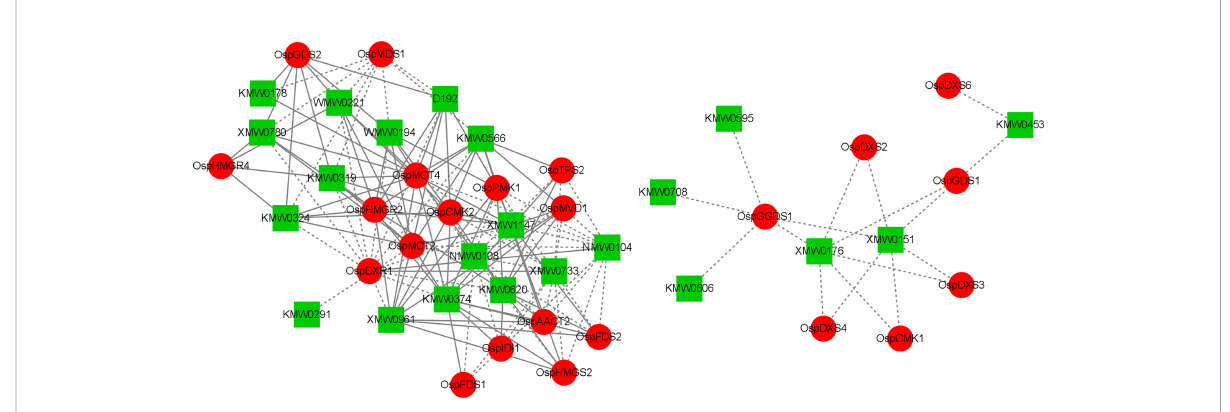
FIGURE 10 Correlation network diagram (red circles indicate genes; green rectangles indicate metabolites; solid lines indicate positive correlations; dashed lines indicate negative